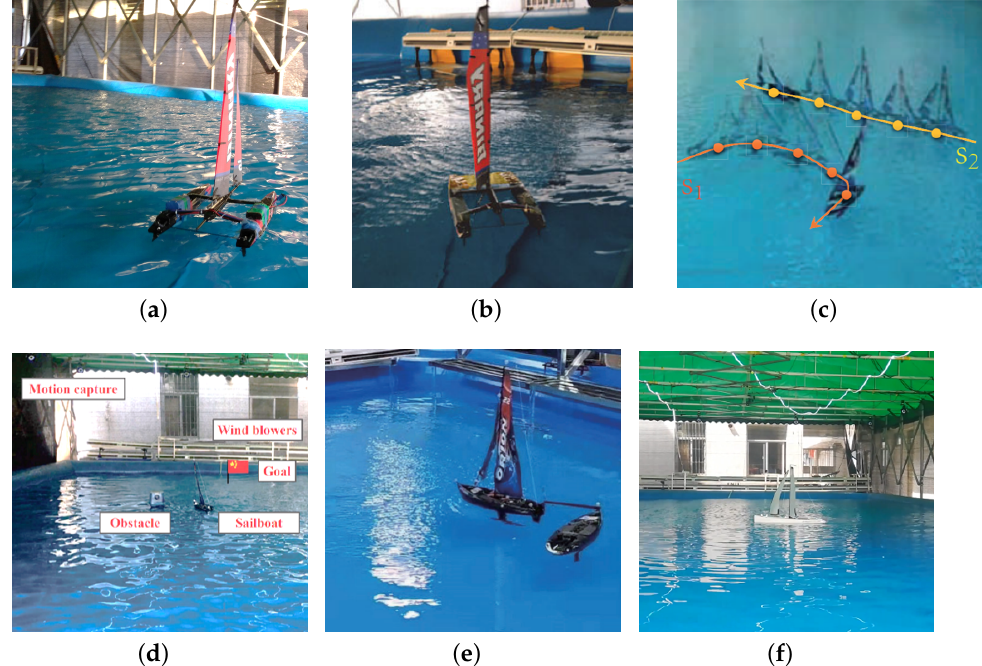
Figure 15. Previous works. ( a ) Automatic sailing with miniSailBot-B. ( b ) Automatic sailing with miniSailBot-C. ( c ) Collision avoidance by racing rule of sailing (RRS) with miniSailBot-D. ( d ) Collision avoidance by reinforcement learning (RL) with miniSailBot-D. ( e ) Enhanced autonomous sailboat with miniSailBot-D. ( f ) Station keeping with